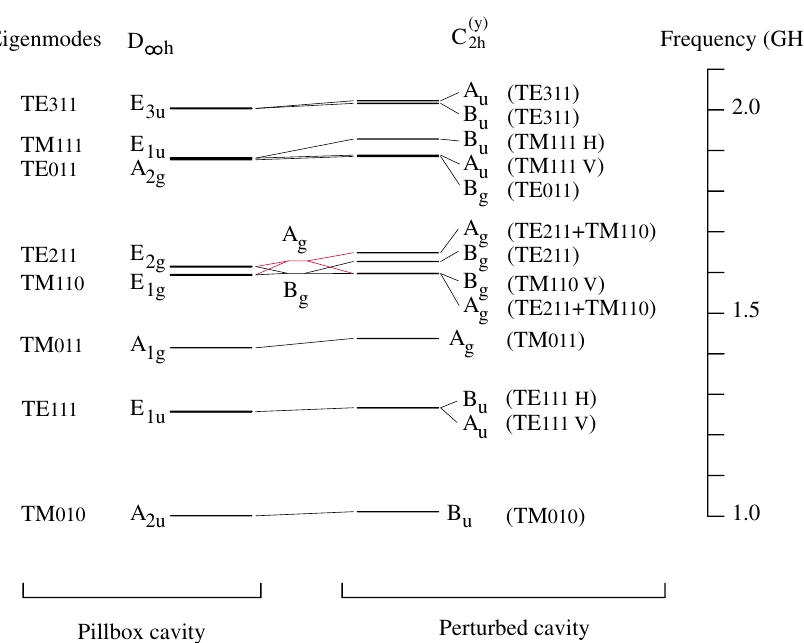
FIG. 4. (Color) Eigenmode spectra for the original pillbox cavity and for the perturbed cavity (in Fig. 3). Every eigenfrequency is indicated by a horizontal line, together with its classification according to the irreducible representation. Thick lines for the pillbox cavity indicate twofold